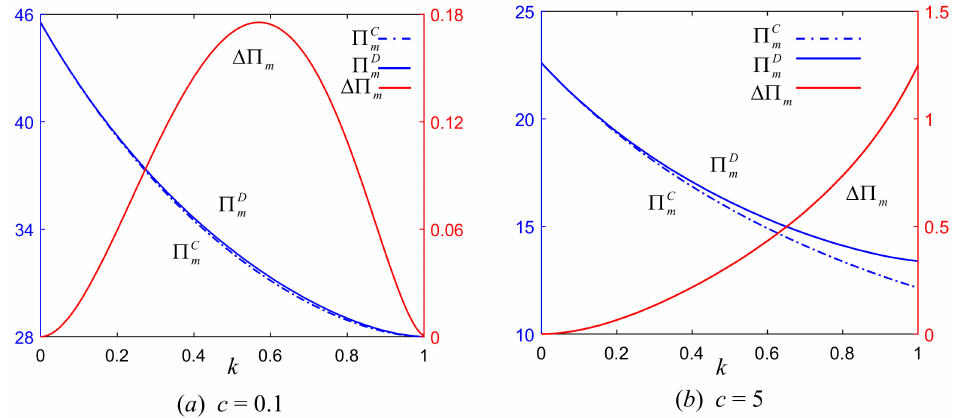
Figure 2. The effect of k on the manufacturer’s profit improvement.